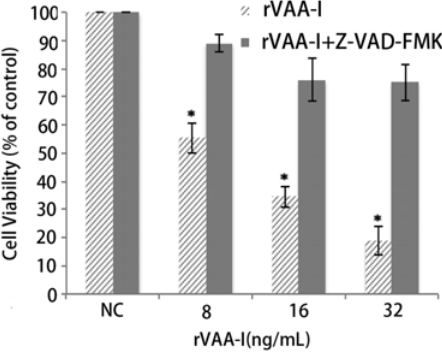
Figure 4. Effect of caspases in SMMC-7721 cells treated with rVAA-I. SMMC-7721 cells untreated or treated with 50 μ m Z-VAD-FMK for 30 min, and then treated with 8, 16, 32 ng/mL rVAA-I. The result measured with MTT. Standard error represents four independent